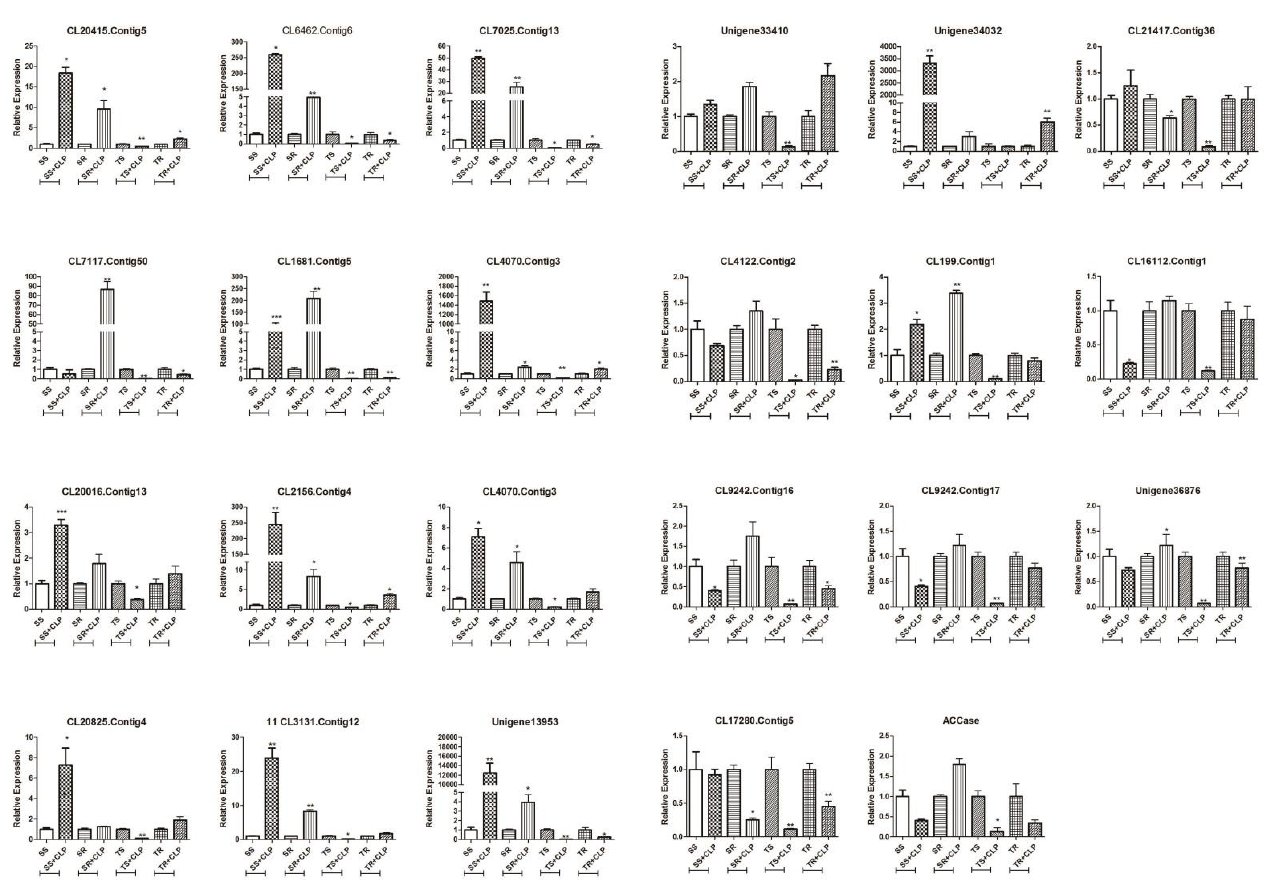
Figure 4. qRT-PCR validation of candidate NTSR gene expression in the intra-group comparison (application/no application in the same population). Three replicates were performed for each of three biological replicates. The standard error of the mean is shown by the error bars. SS: susceptible population in the seedling stage; SR: resistant population in the seedling stage; TS: susceptible population in the tillering stage; TR: resistant population in the tillering stage; +CLP: application of clodinafop-propargyl. * p < 0.05, ** p < 0.01, *** p <